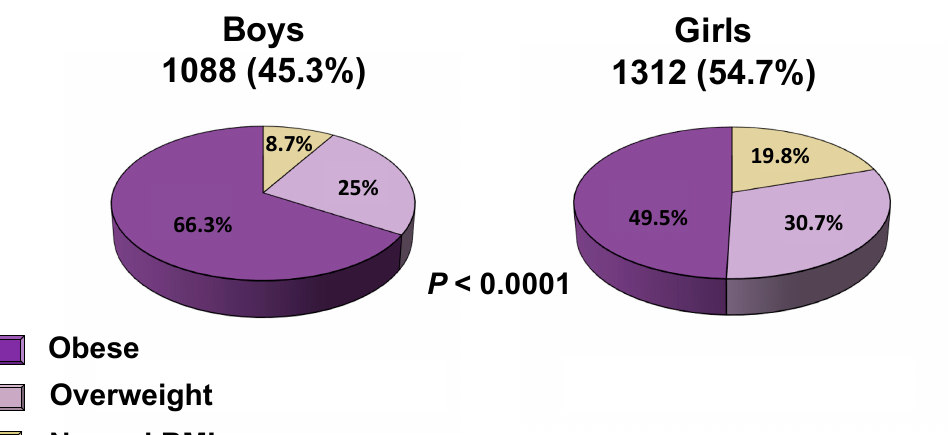
Figure 1. Distribution of BMI: ( A ) in all subjects, ( B ) according to gender.